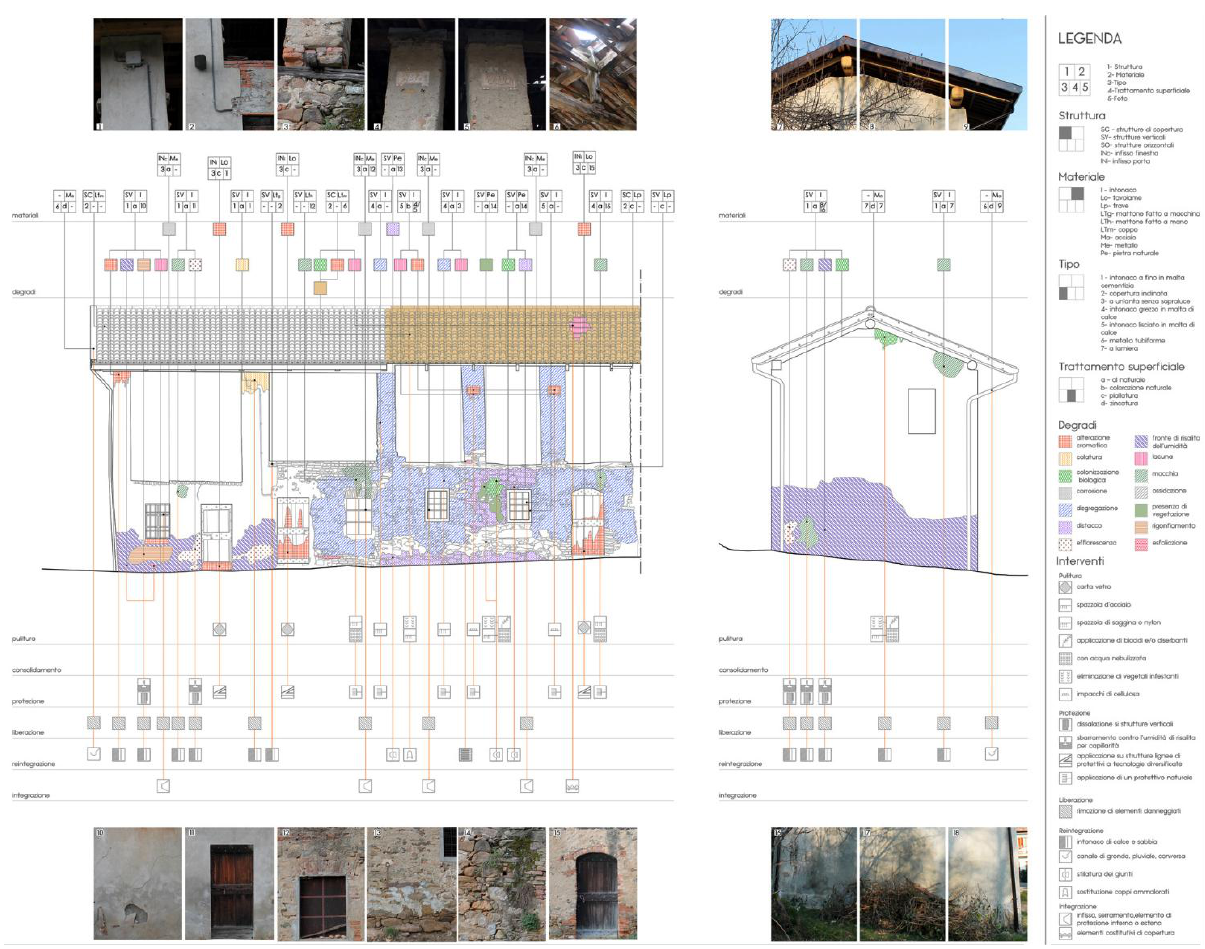
Figure 1. Example of a restoration project: from the analysis of materials and decays to the interventions'